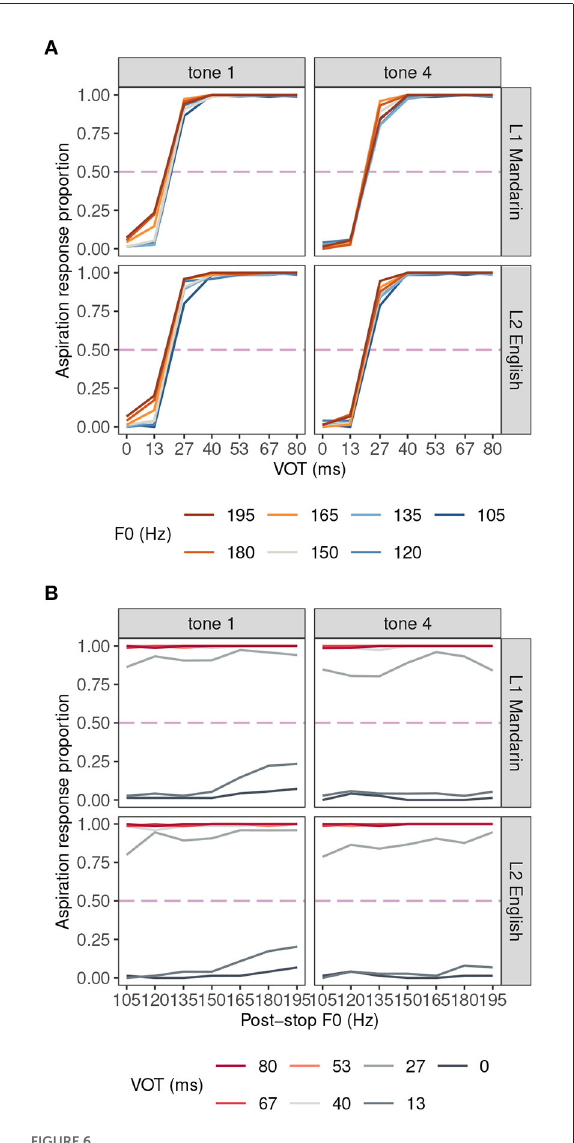
FIGURE6 Line charts of Mandarin-English bilinguals’ aggregated categorization of word-initial stops in each language, shown as a function of VOT, post-stop F0, and tone. (A) With VOT on the x -axis. (B) With post-stop F0 on the x -axis to highlight its effect on